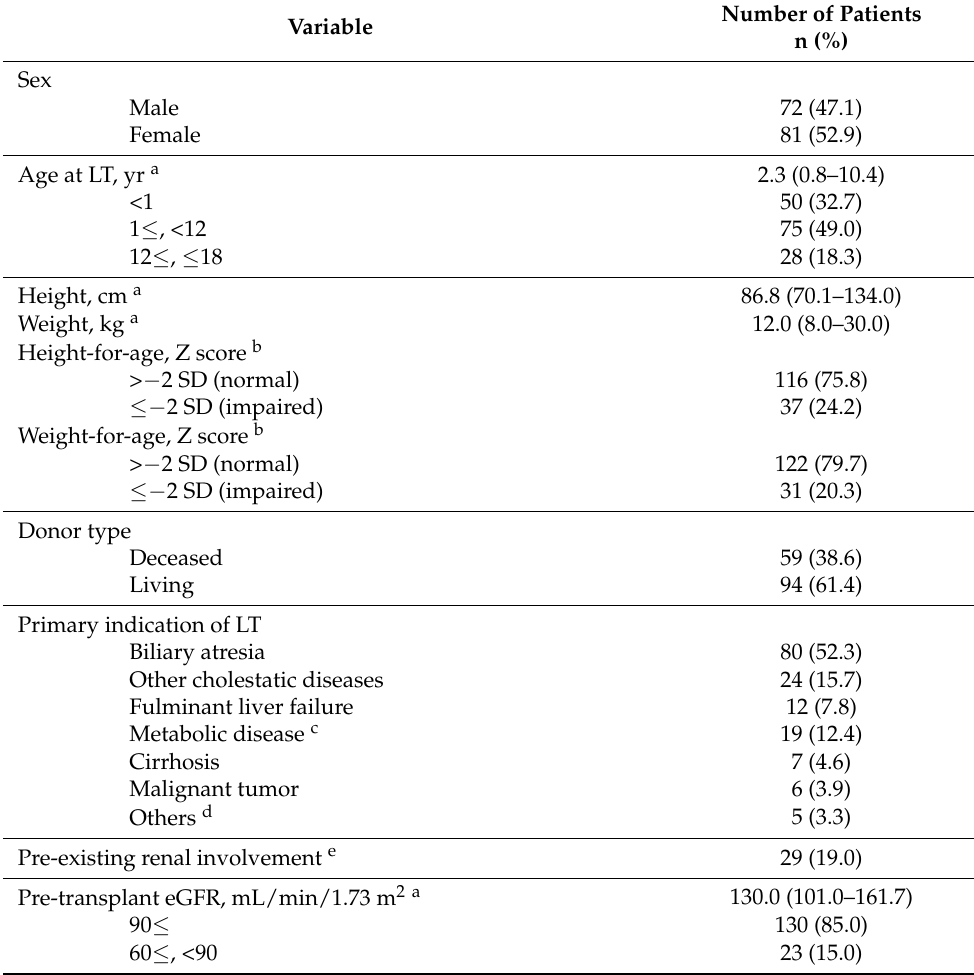
Table 2. Baseline characteristics of the patients for kidney function preservation analysis (n =